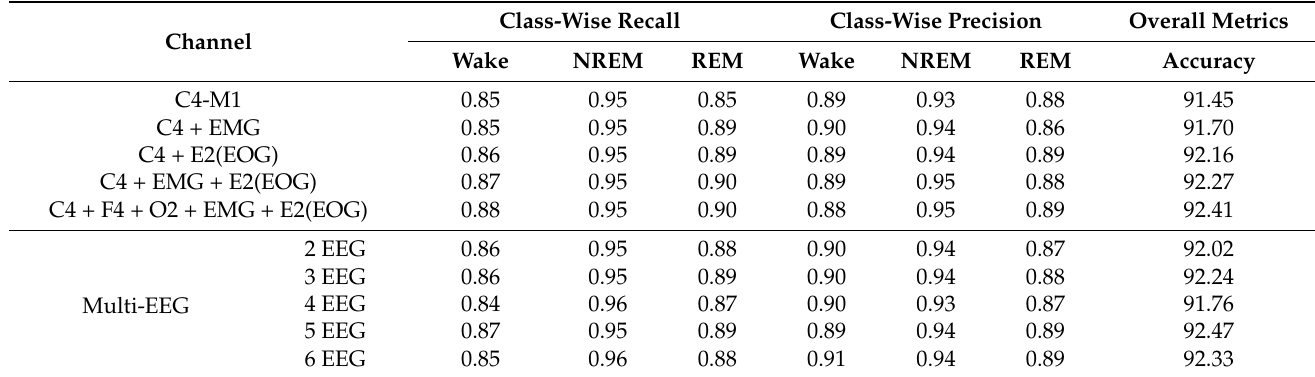
Table 7. Deep learning model performance according to channel